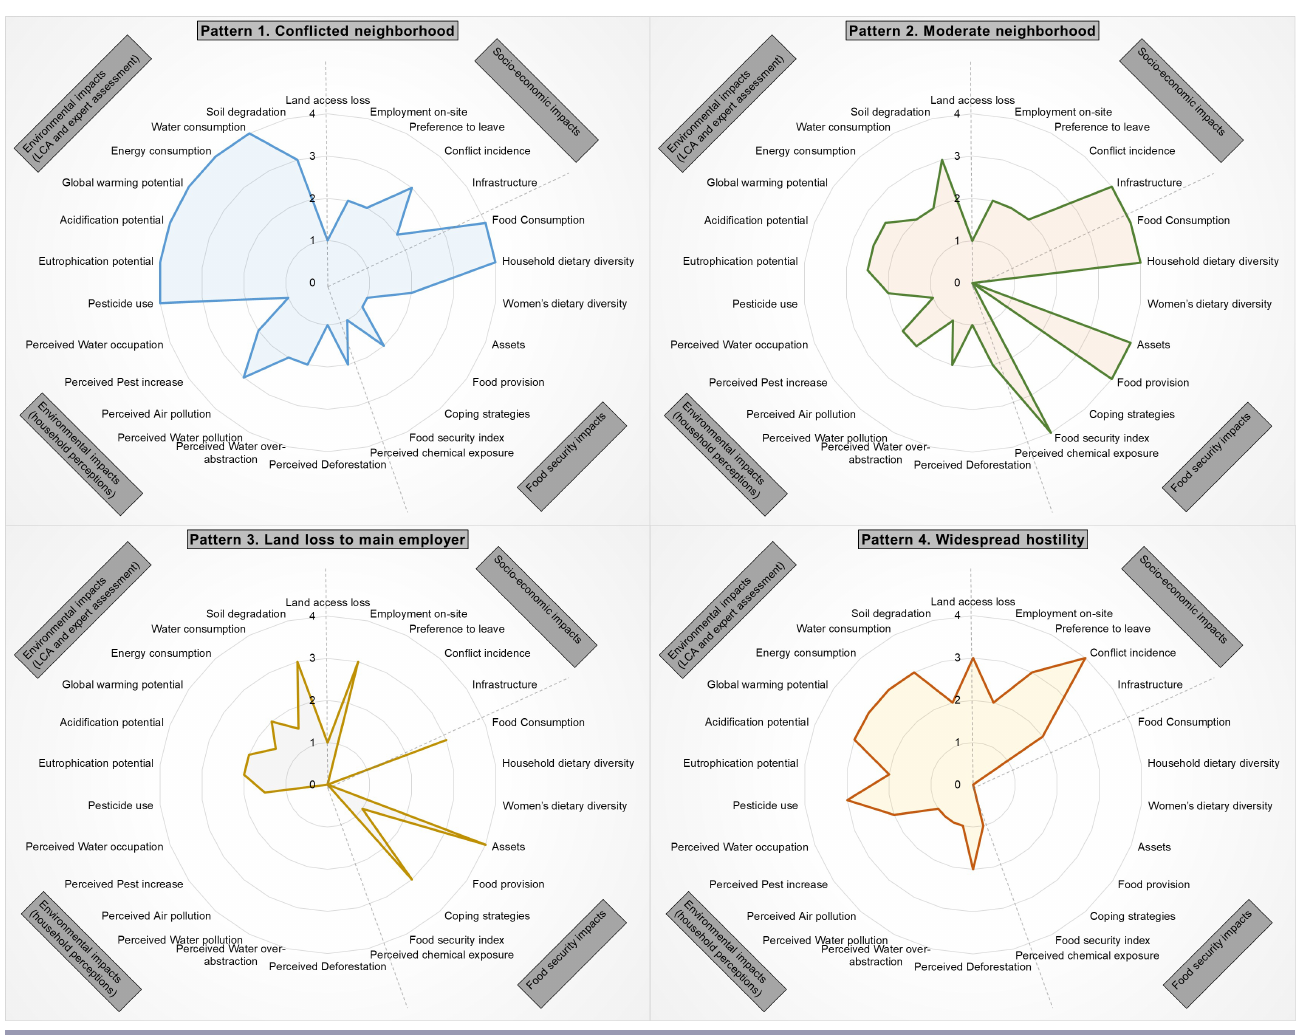
Fig. 2. Profiles of the four impact patterns. Note: the scale denotes the strength of the impact from 1 (no impact) to 4 (strong impact), with 0 (no data). It does not denote a judgement as to whether this impact is “good” or